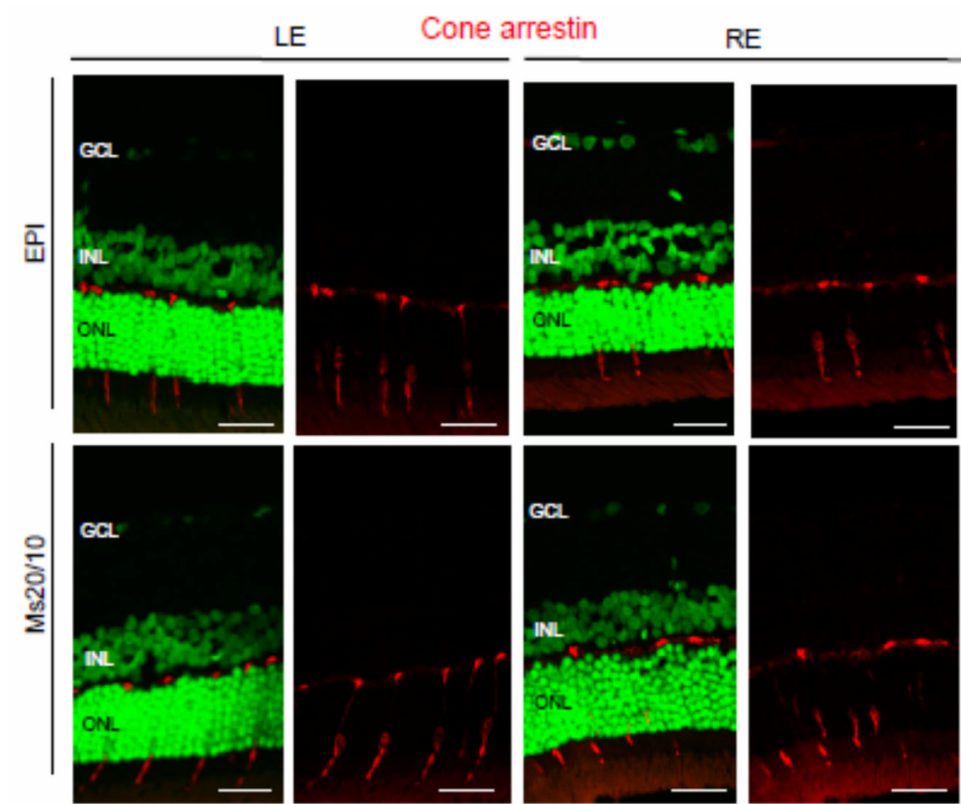
Figure 13. Cone arrestin expression in glaucomatous the EPI and Ms20/10 models. Representative images showed the location and total volume of cone arrestin observed in the retinas. GCL: ganglion cell layer; INL: inner nuclear layer; ONL: outer nuclear layer; LE: left eye (control); RE: right eye (treated). Scale bar: 30.86 µ